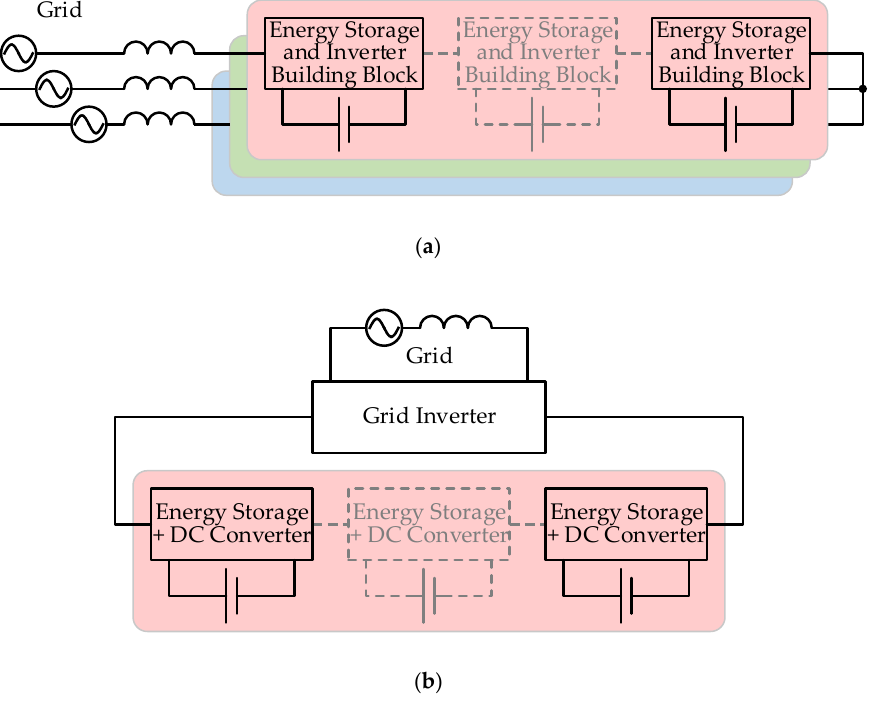
Figure 13. Functional diagrams of cascaded H-Bridge multilevel converters: ( a ) traditional configuration of AC MLC, ( b ) configuration DC MLC with unipolar cell converters and grid frontend.